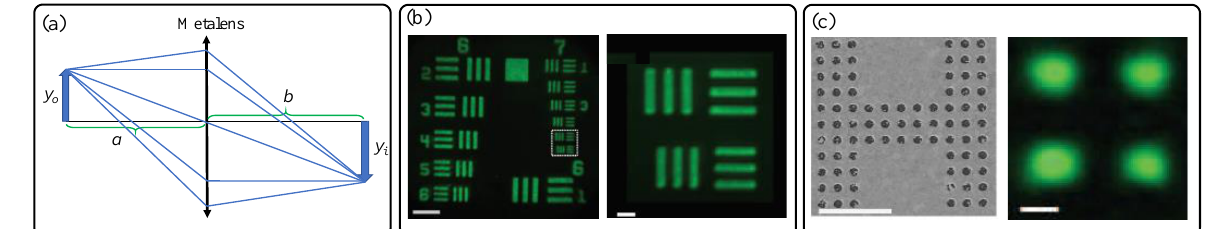
Figure 3. ( a ) Schematic diagram describing the simple object imaging relation of a flat hyperbolic metalens. ( b , c ) Nearly diffraction-limited object imaging performances of the TiO 2 nanofin metalens by Capasso group in 2016 [9]. Experimentally captured camera images of ( b ) 1951 United States Air Force (USAF) resolution test chart and ( c ) nano-scale metallic hole arrays, formed by the TiO 2 nanofin metalens at the wavelength of 532 nm. The scale bars in ( b ) and ( c ) denote 40 µ m, 5 µ m, 10 µ m, and 500 nm, from the left to right, respectively. ( b , c ) Reprinted with permission from [9]. Copyright 2016 The American Association for the Advancement of Science.